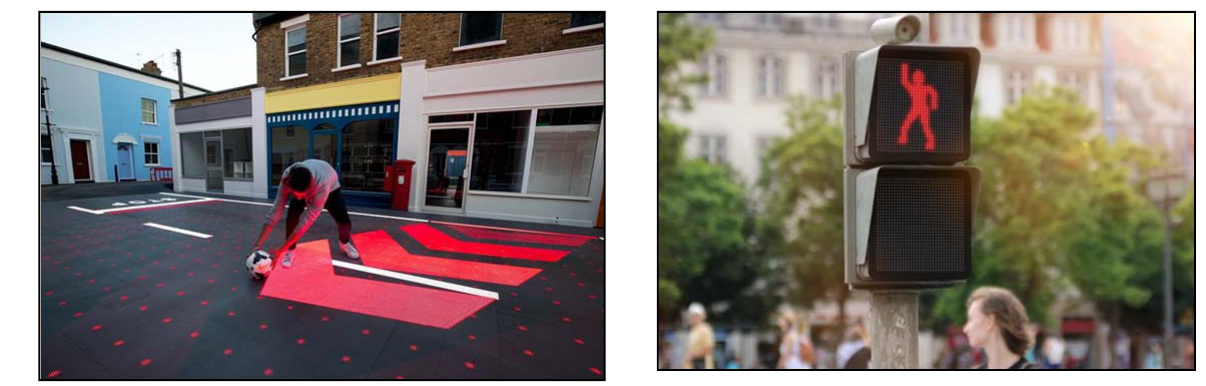
Figure 9. Proiectul The Starling Crossing. Figure 10. Semaphor „ dancer ”